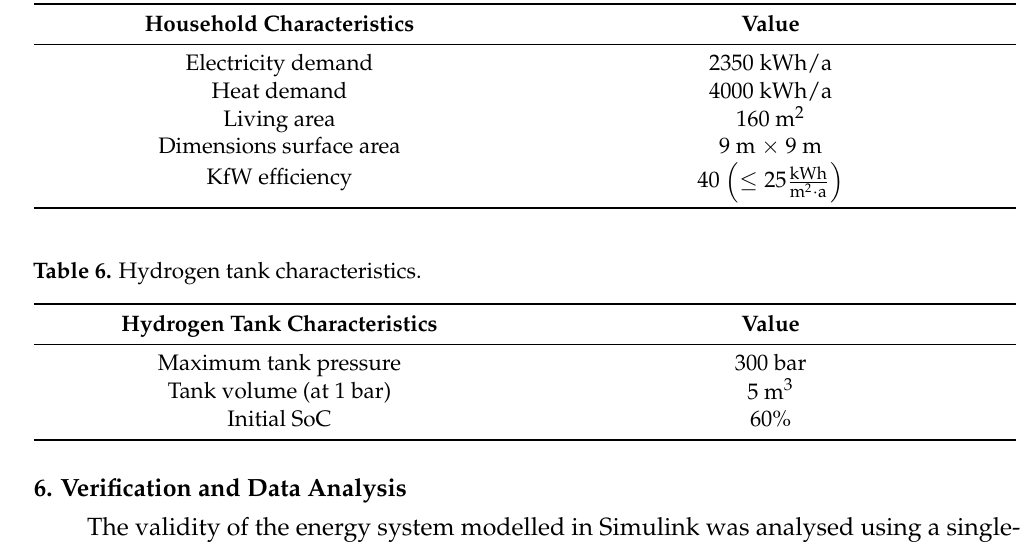
Table 5. Household characteristics.